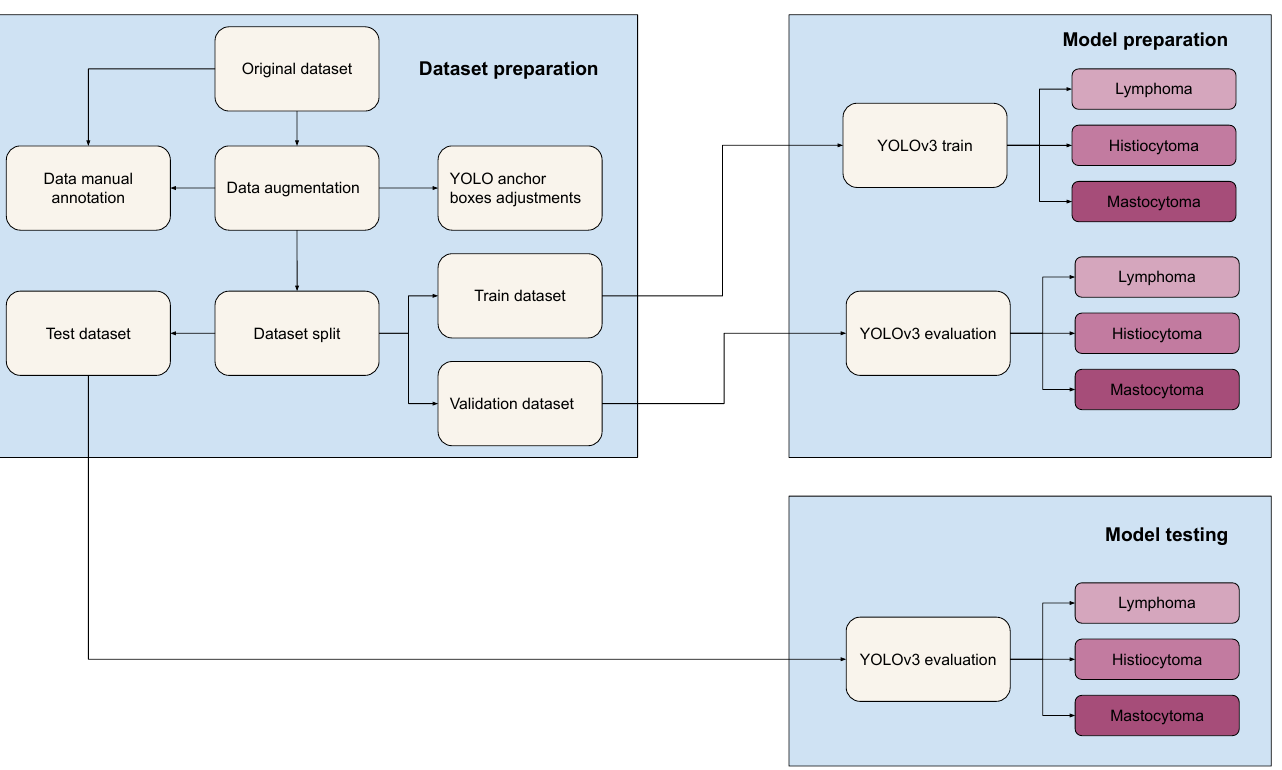
Figure 8. Training and testing flow.